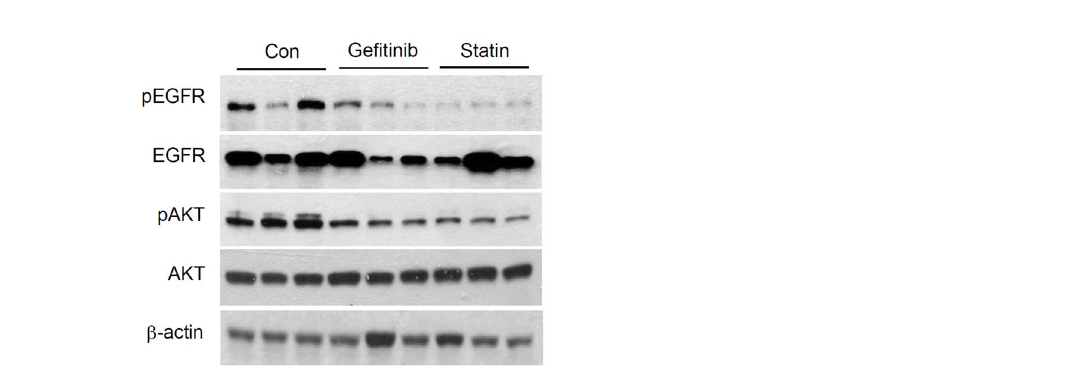
Fig. 4. Effects of gefitinib and statin treatments on the serum lipid profile. Changes in serum lipids after 6 weeks of gefitinib or statin treatment. (A) Total cholesterol, (B) HDL cholesterol, (C) LDL cholesterol, (D) triglyceride levels (n 5 10 each, P , 0.05). Values represent the means ¡ SEM. * P , 0.05 relative to baseline. & P , 0.05 relative to Con, # P , 0.05 relative to G. N-C, normal control; HFD, high-fat diet; Con, control; G, gefitinib; S, statin.